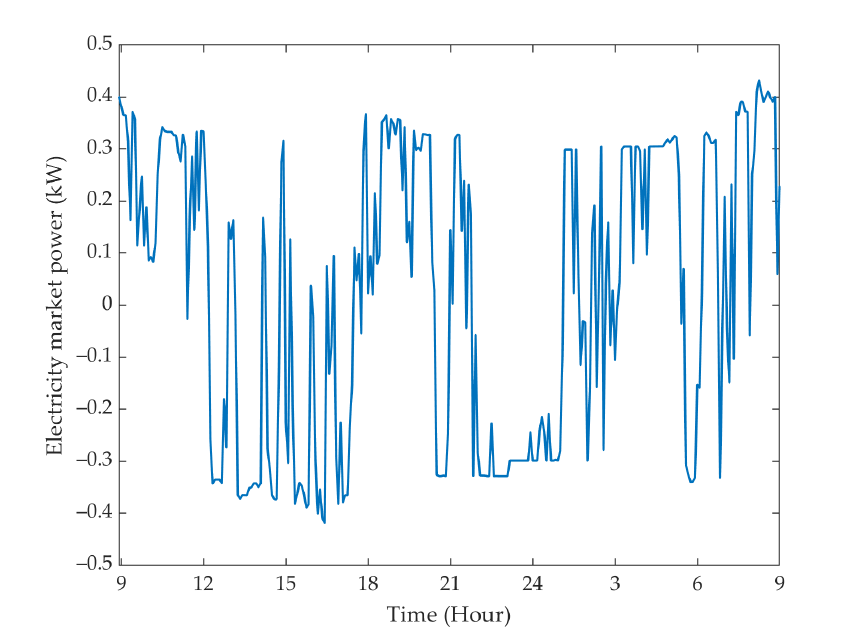
Figure 7. Electricity market power profile to cover the mismatch between the reference signal and EV s power.